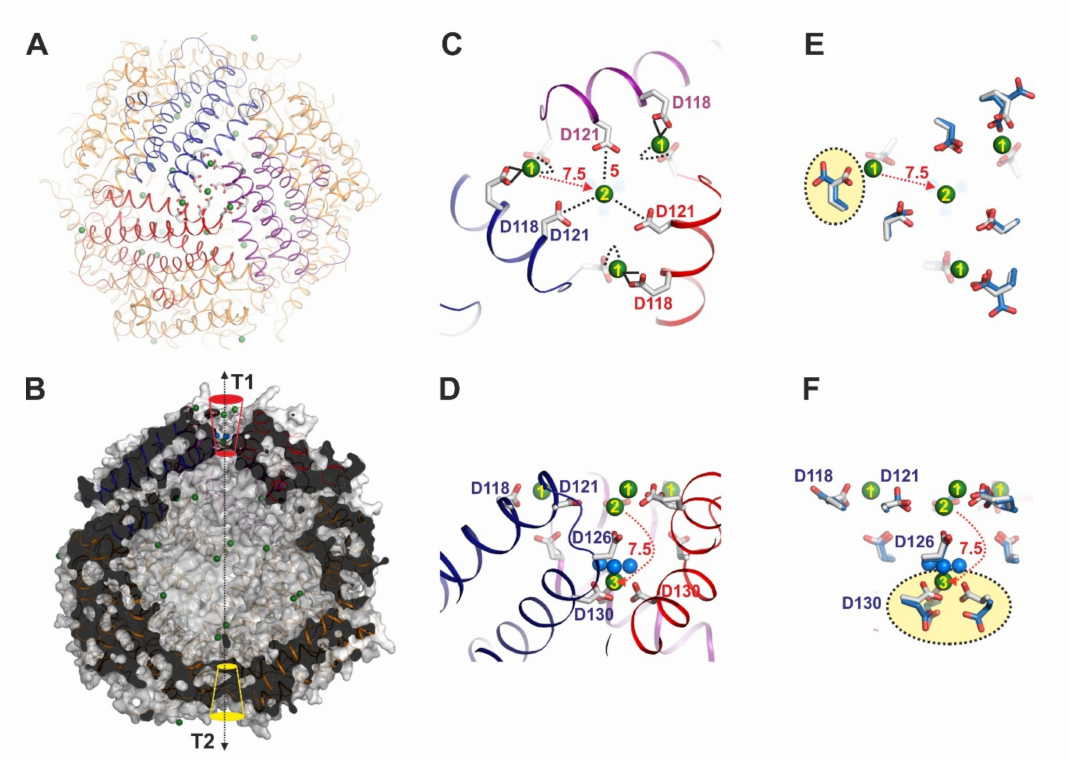
Figure 2. Architectures and uptake mechanism of Yb 3+ ions through the T1 uptake pore of Li Dps with Yb 3+ incubated for 30 min with Li Dps crystals (Dps Yb 30). ( A ) Architecture of the T1 pore viewed from the top of Dps Yb 30 shown in cartoon representation. ( B ) The surface representation of Dps Yb 30 is shown; the subunits are marked in cartoon representation, with the arrangement of T1 (in red color) and T2 (in yellow color) pores located at opposite sides of the protein cage. ( C ) Architecture of the T1 pore viewed from the top. Yb 3+ ions are shown as light green spheres with positions termed 1–3 and distances of 7.5 Å between positions 1 and 2, and 7.5 Å between positions 2 and 3, respectively. The residues of one subunit along the 3-fold axis are represented by sticks and marked according to the amino acid sequence. Dotted lines indicate interaction of Yb 3+ with side chains. ( D ) Architecture of the T1 pore viewed from the side. ( E ) The residues in Figure 2C of one subunit along the 3-fold axis are represented by sticks and marked according to the sequence. The side chain Glu118 and Asp130 are colored yellow and are significant dynamics. ( F ) The residues in Figure 2D of one subunit along the 3-fold axis are represented by sticks and marked according to the